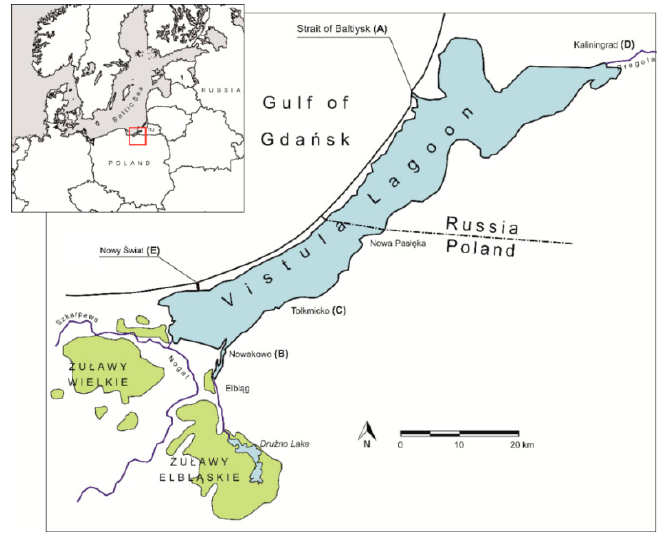
Figure 1. Location of the Vistula Lagoon [4].